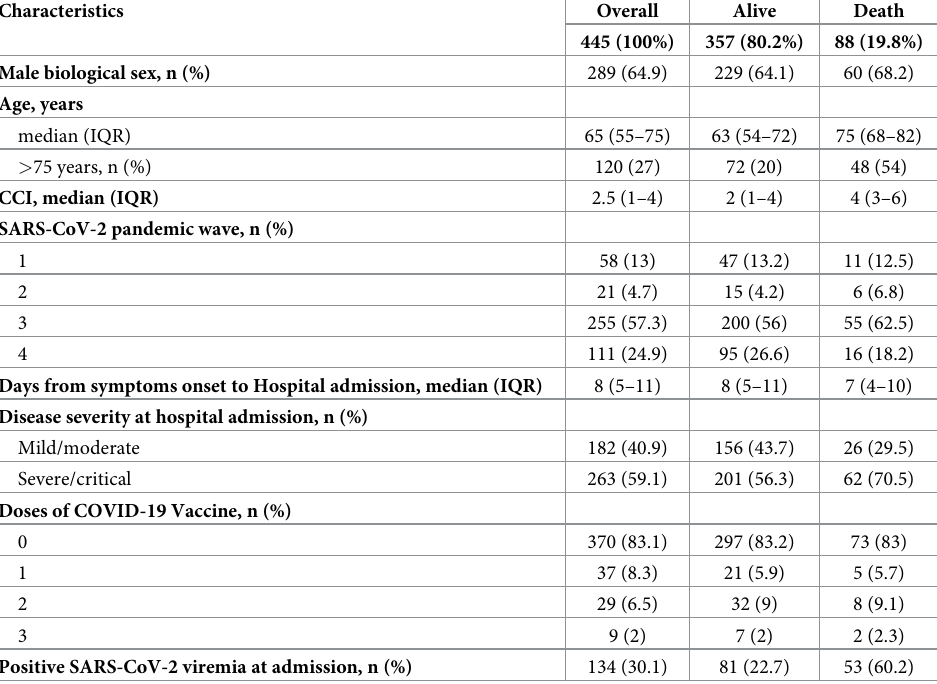
Table 1. Characteristics of the study population according to being alive or death after hospitalization for COVID-19. Characteristics